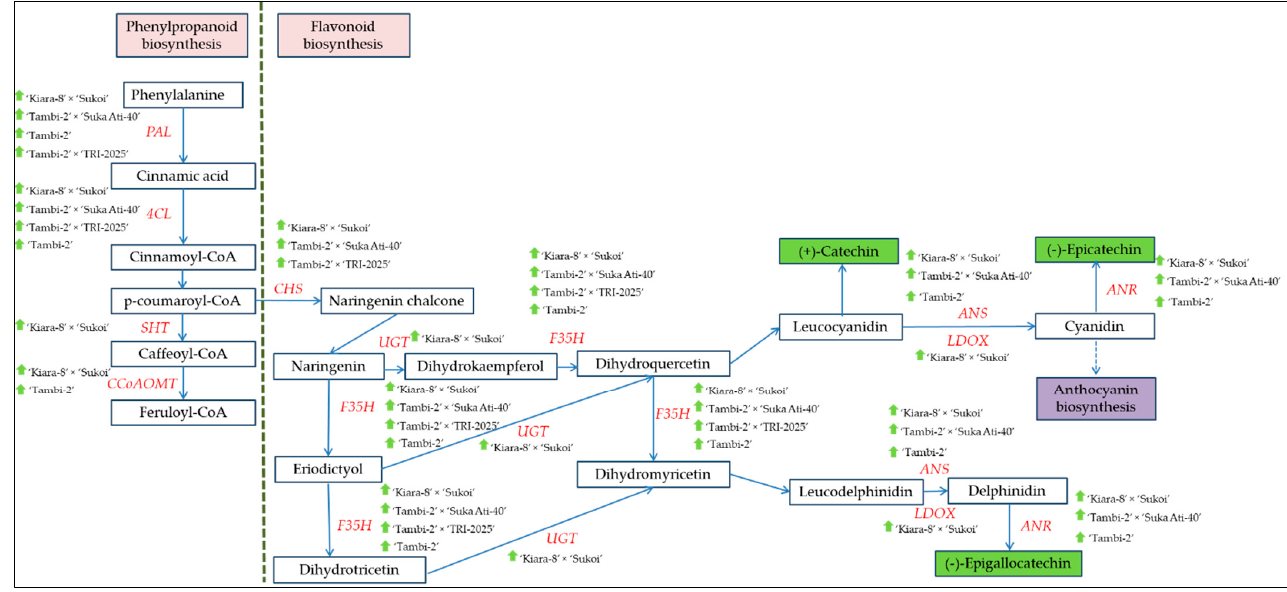
Figure 8. Diagram of the genes (red) influencing the formation of EGCG and C and their up-regulation ( ) in hybrid progenies and clone-cultivars.